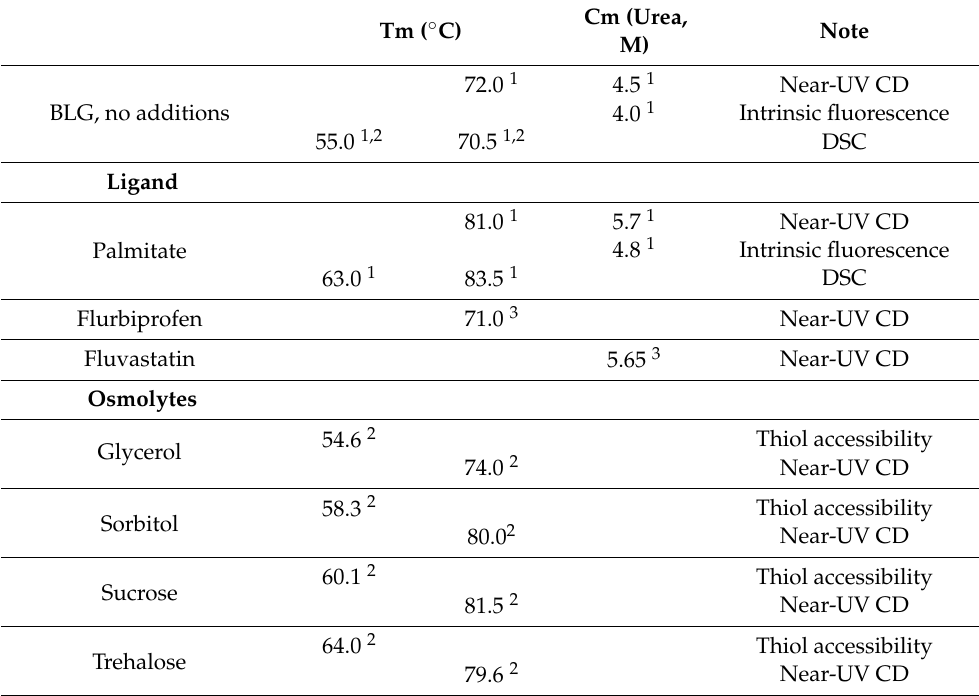
Table 2. Denaturation midpoints (temperature or chaotrope concentrations) for BLG in the pres- ence/absence of ligands and of other components in the